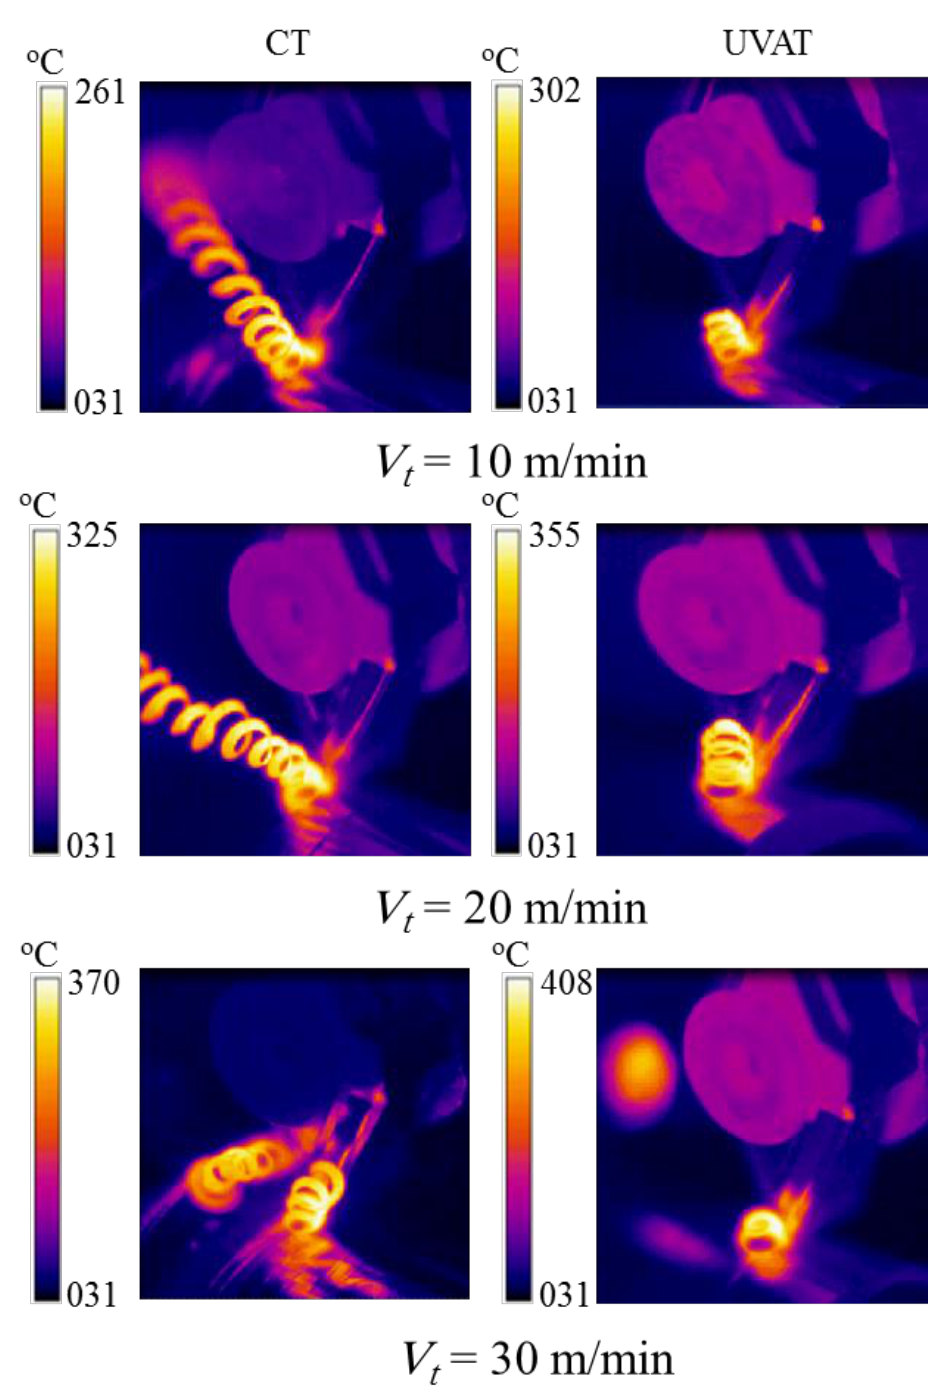
Figure 13. Measured temperature in CT and UVAT. The studied alloys resulted in discontinuous chips in the CT and UVAT processes in all of the tested conditions. The chips were analyzed for CRR and SA calculations. The chip size produced during UVAT was substantially smaller when matched to the chip produced during CT in the same cutting conditions. The discontinuity of the chips resulted from the addition of Nd , which has a lower melting temperature. The chip samples from the UVAT and CT processes are presented in Figure